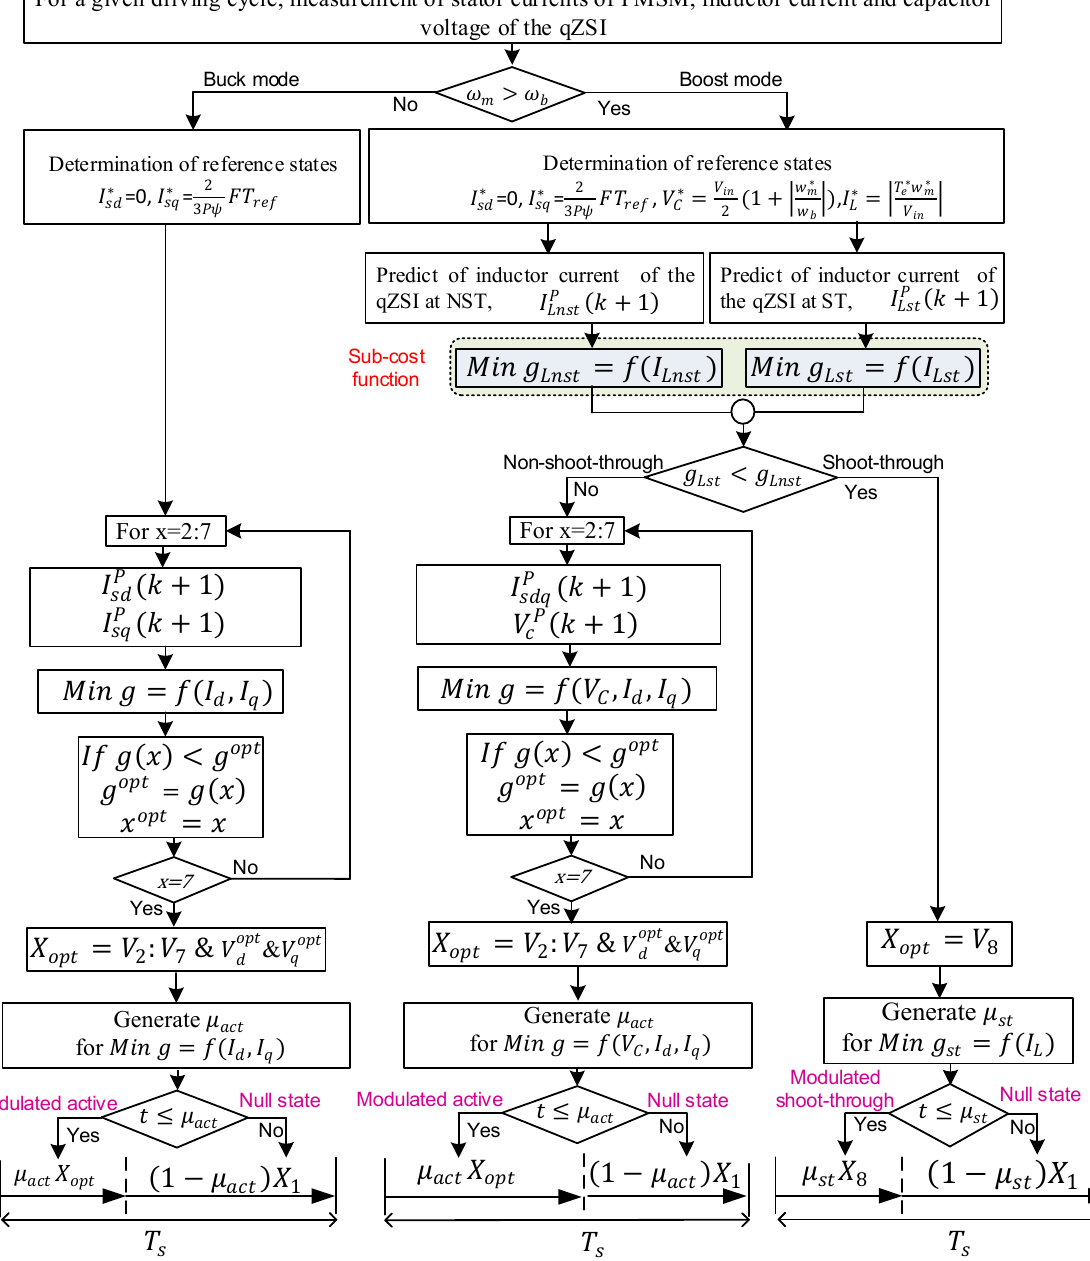
Figure 4. Flowchart of the proposed modulated FCS-MPC algorithm for qZSI applied to PMSM drives.